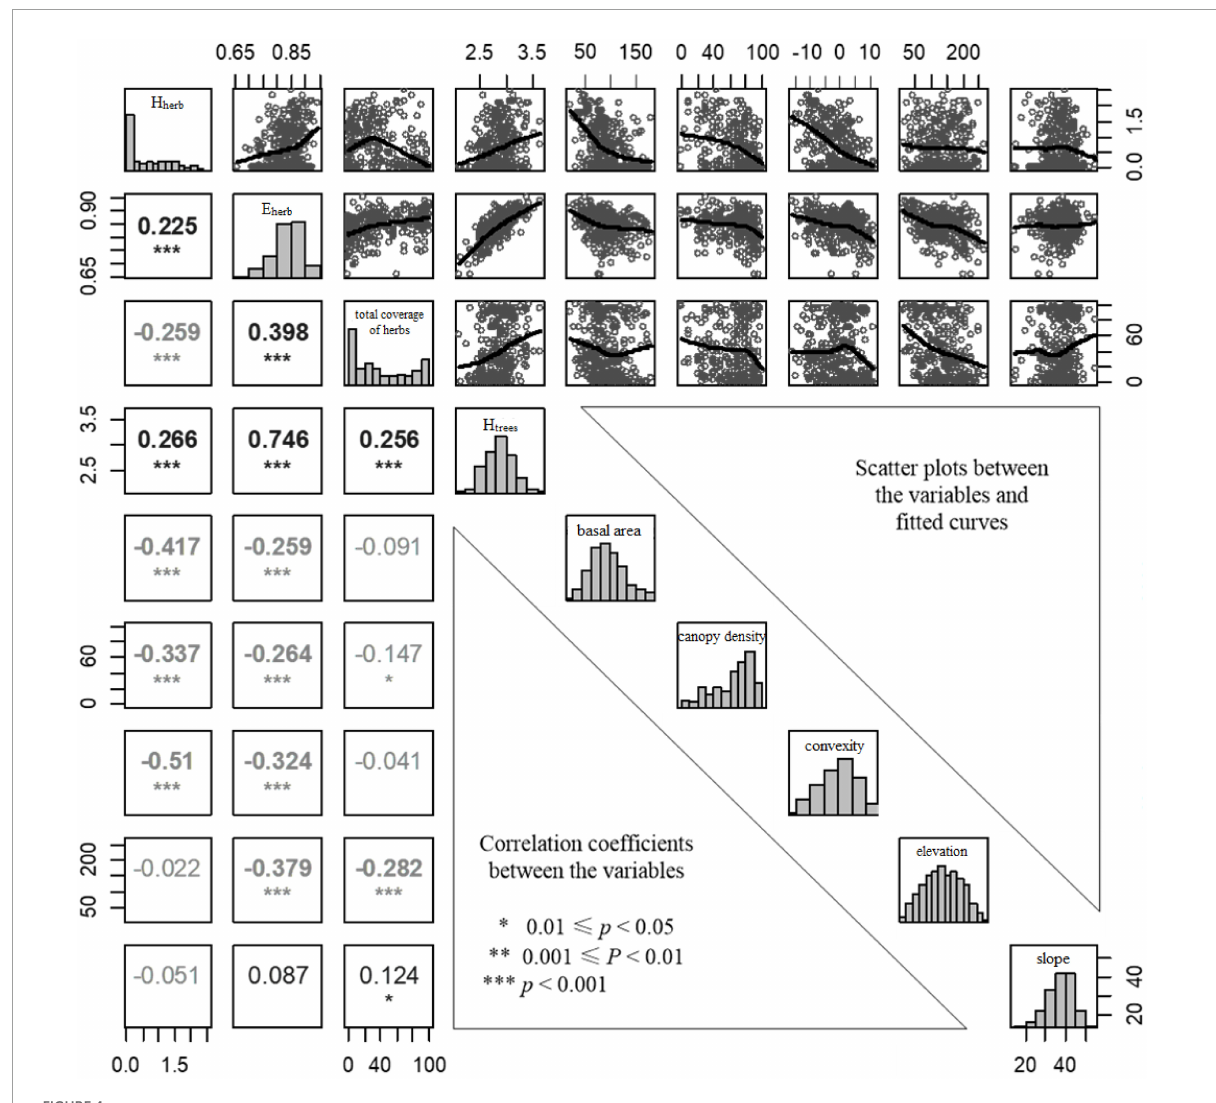
FIGURE4 Correlation matrix of nine herbaceous plant community and environment variables in Gutianshan subtropical understory. Histograms of variables were shown on the diagonal, scatter plots between the variables were shown on the upper panel, and the lower panel showed Pearson correlation coefficients, where gray represents negative